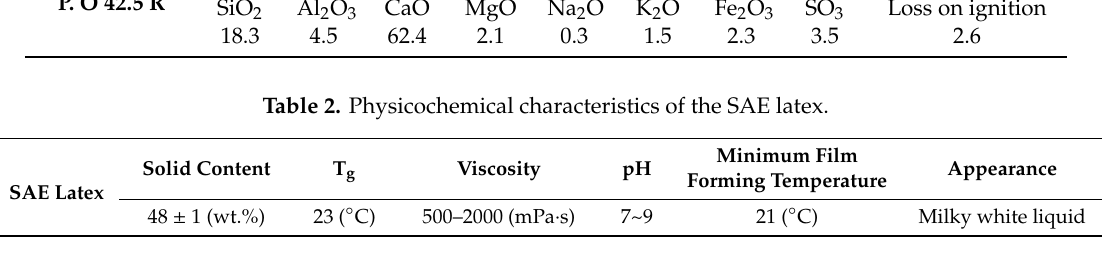
Table 3. Properties of carbon nanotubes (CNTs).